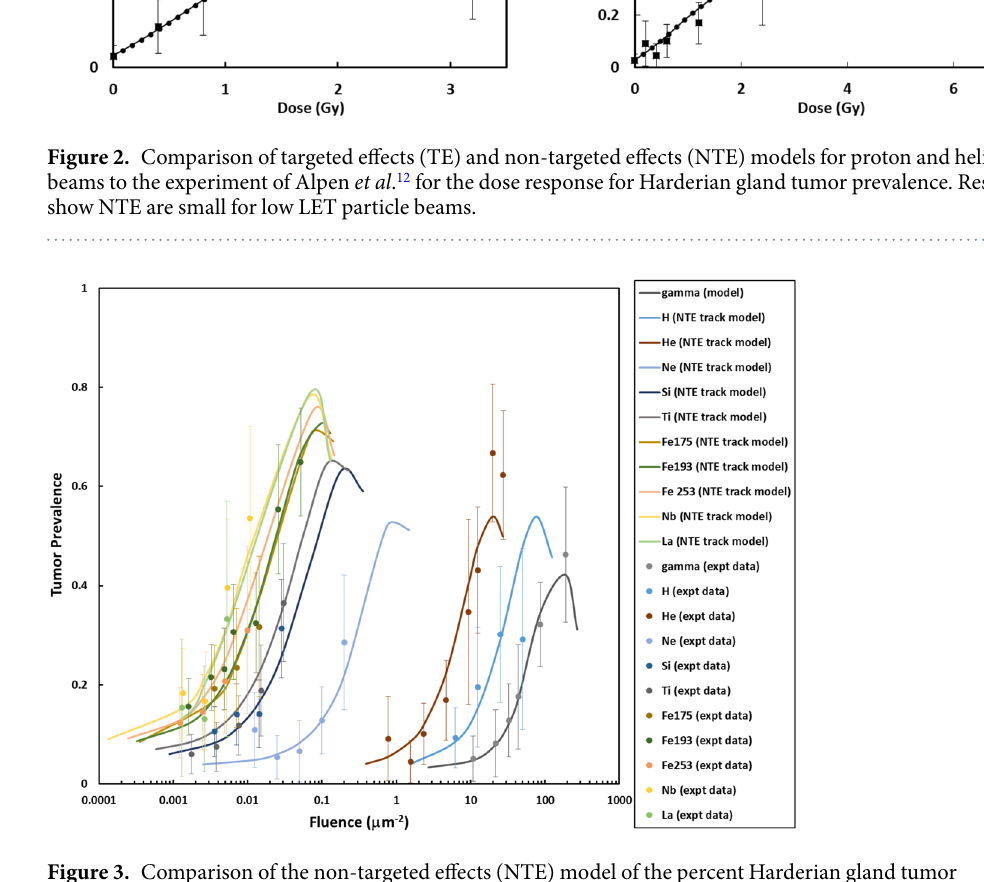
Figure 3. Comparison of the non-targeted effects (NTE) model of the percent Harderian gland tumor prevalence versus particle fluence to experiments of Alpen et al . 12, 13 and Chang et al . 14 . Error bars represent standard errors in the experiments.